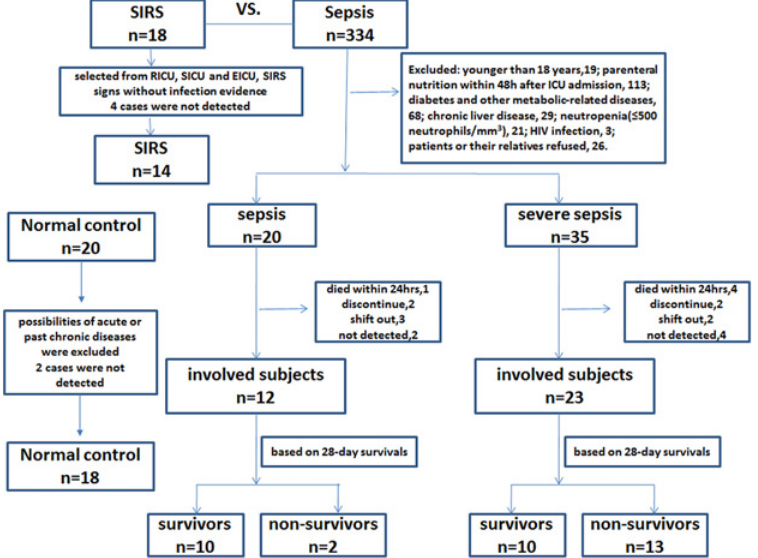
Fig 1. Trial profiles of the patients enrolled in our study. A total of 55 out of 334 septic patients were selected based on the relevant criteria. The sepsis group was further divided into sepsis (n = 12) and severe sepsis (n = 23) subgroups, as well as into survivor (n = 20) and non-survivor (n = 15) subgroups. Additionally, 18 normal controls and 14 SIRS were also included in this